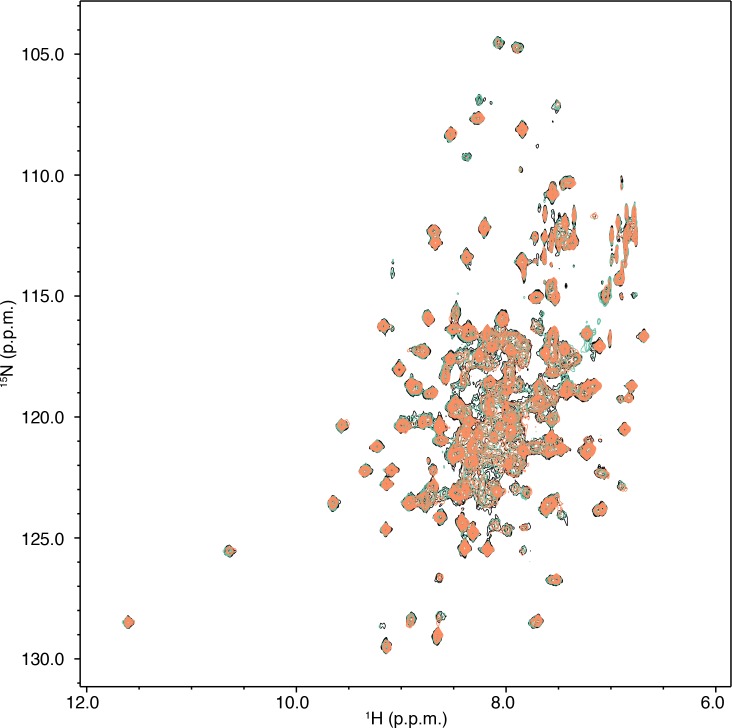
Full differential 2D [1H,15N]-TROSY-HSQC NMR data comparing 15N-PPARγ LBD in the native form (orange) vs. delipidated using a refolding procedure (black) or treatment using LIPIDEX 1000 resin (green), the latter two of which are nearly identical and show an increase in the intensities of some peaks vs. native.